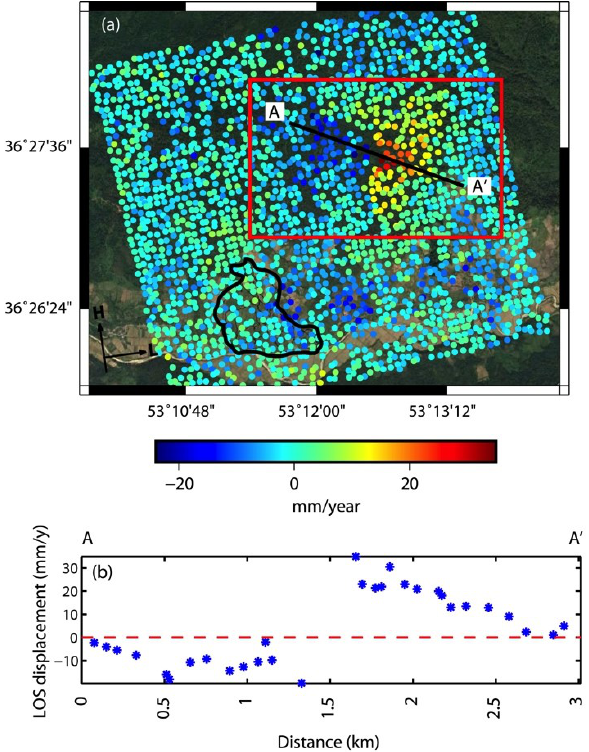
Figure 6: (a) LOS displacement map from ALOS dataset over Shabkola landslide. Positive values are moving toward the sensor and negative values are moving away from the sensor in the LOS direction. Black boundary is the Shabkola landslide body measured by GPS stations. Red rectangle shows the active region of the old landslide. H and L vectors show the heading and LOS direction of the satellite. (b) AA' LOS velocity profile depicted by black line in figure